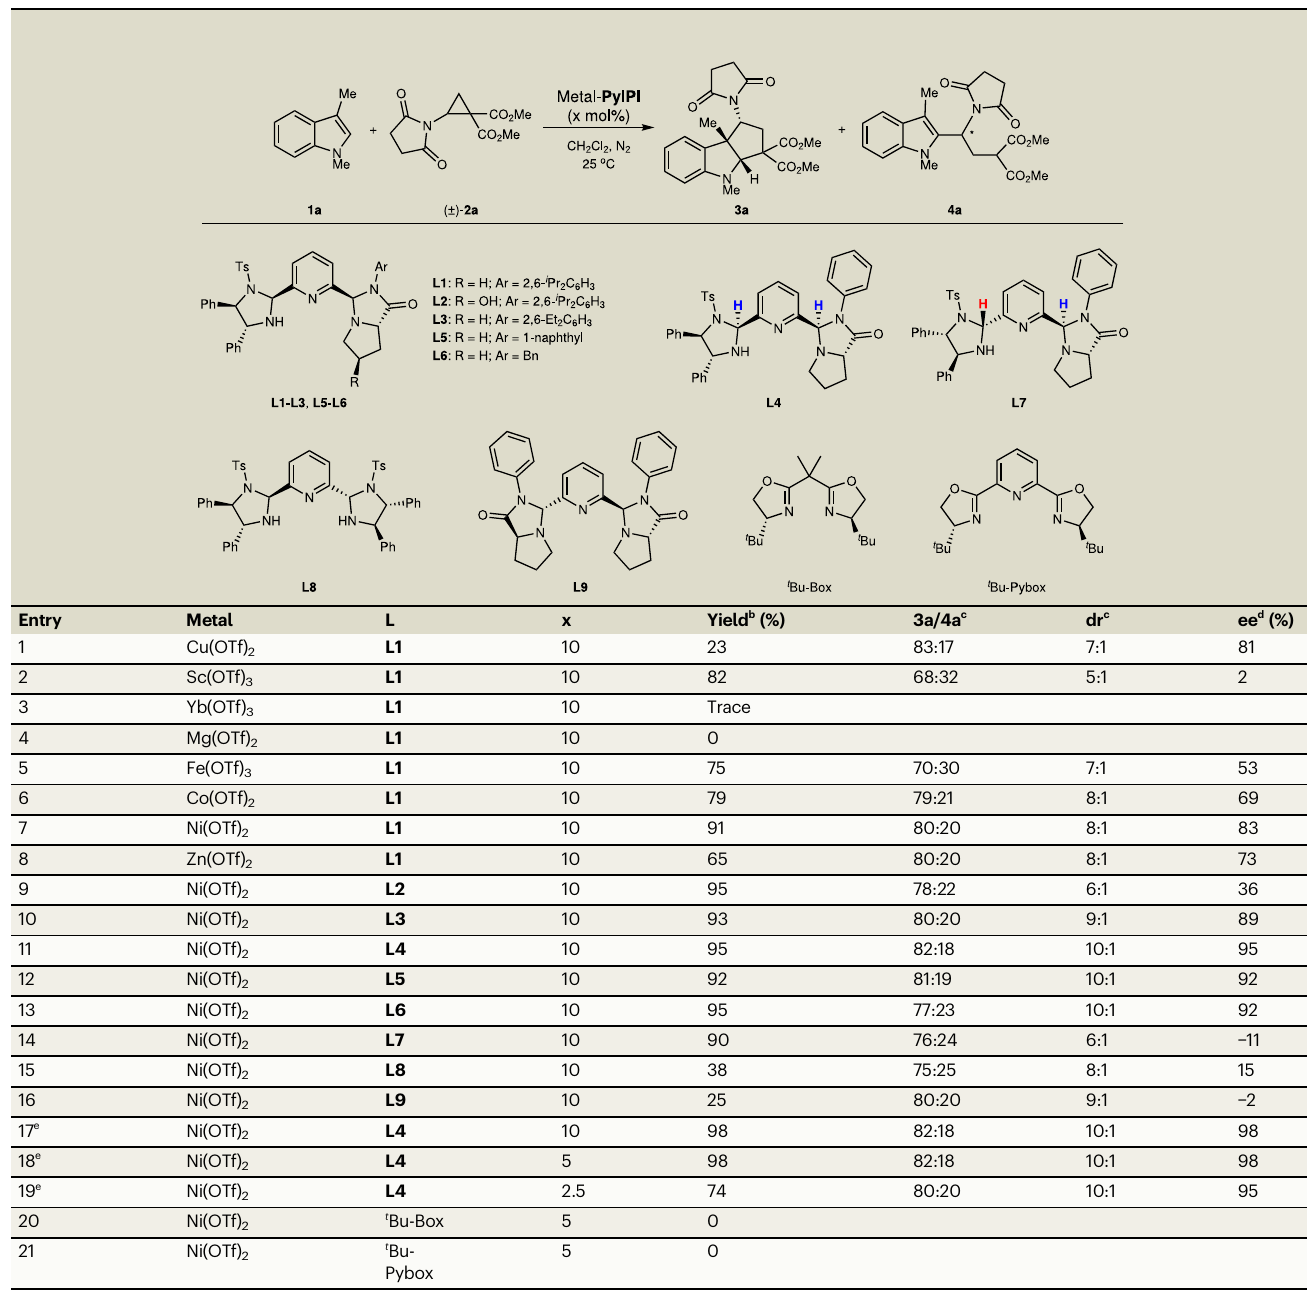
Table 1 | Optimization of the reaction conditions